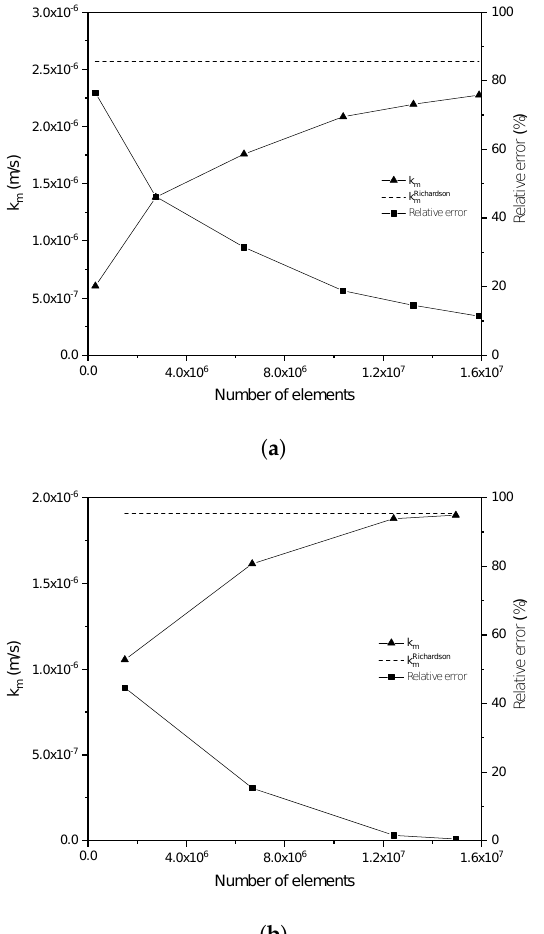
Figure 6. Convergence results for k m in laminar flow with w equal to 0.6 cm and δ equal to 1 cm for ( a ) WME and ( b )